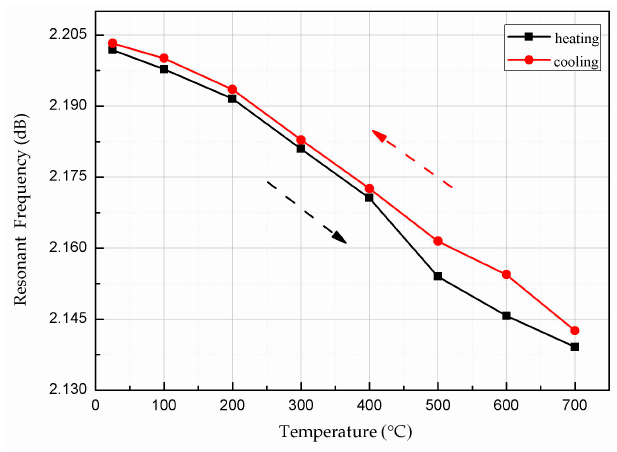
Figure 13. Valley resonant frequency versus temperature during heating and cooling.